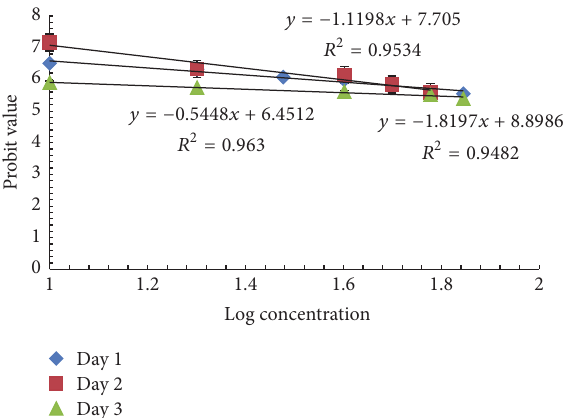
Figure 6: Peleg model kinetic regression line of orientin and vitexin in dried leaves extract ( 𝑛 = 3 ).